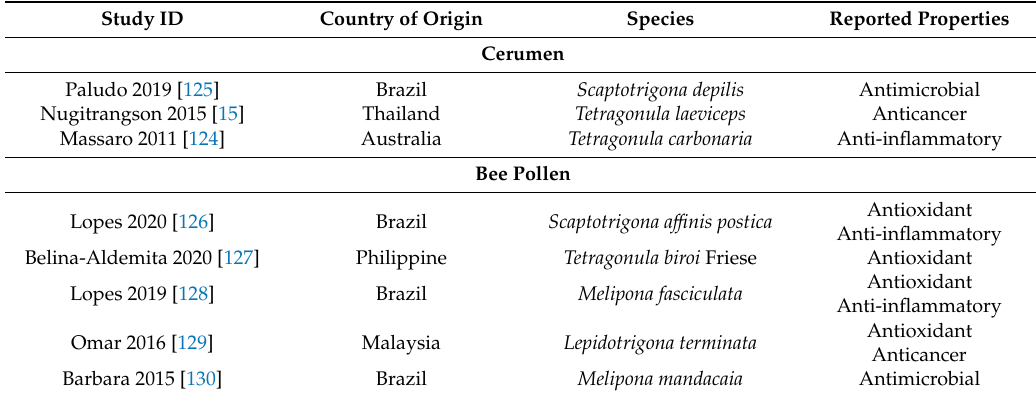
Table 3. List of studies on the potential medicinal properties of cerumen and bee pollen from stingless bees.